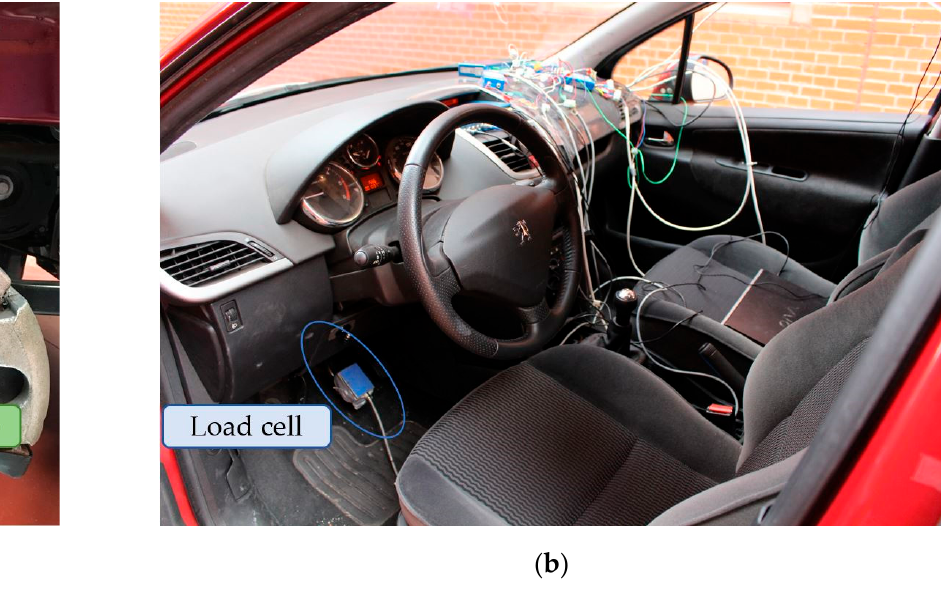
Figure 3. Onboard sensors: ( a ) pressure sensor in the brake circuit and thermocouple on the brake disc and ( b ) load cell on the brake pedal. disc and ( b ) load cell on the brake